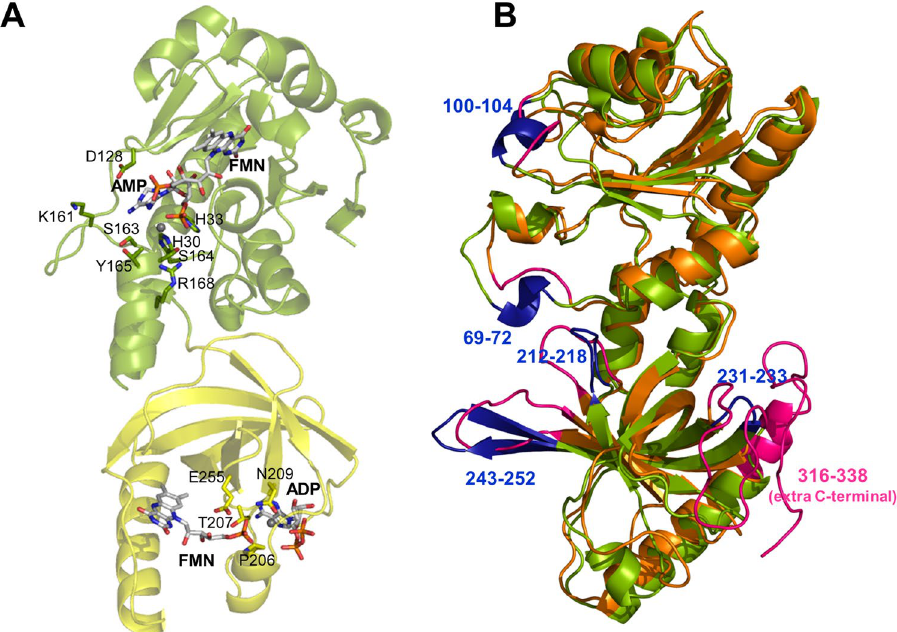
Figure 5. The structure of Spn FADS. ( A ) Model (based on PDB ID: 3OP1) for the interaction of Spn FADS with its ligands. The FMNAT module is shown in green and the RFK in yellow. Flavin and adenine nucleotide ligands are in CPK colored sticks with carbons in white. Mg 2 + ions are shown as grey balls. Modelling performed using PyMol. ( B ) Superposition of the structures of Spn FADS (green, PDB ID: 3OP1) and Ca FADS (orange, PDB ID: 2X0K). Dissimilar regions are highlighted in blue and pink, respectively, including the numbers of implicated residues in Spn